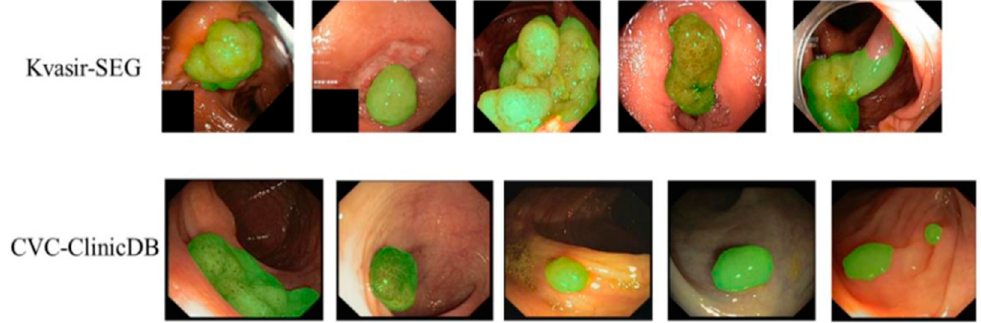
Figure 7. The visualization results of GCCSwin-UNet.